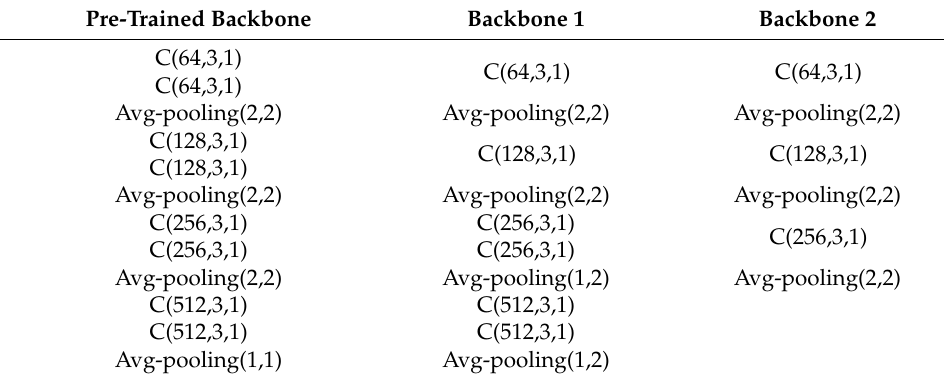
Table 2. Backbones are used in this paper.